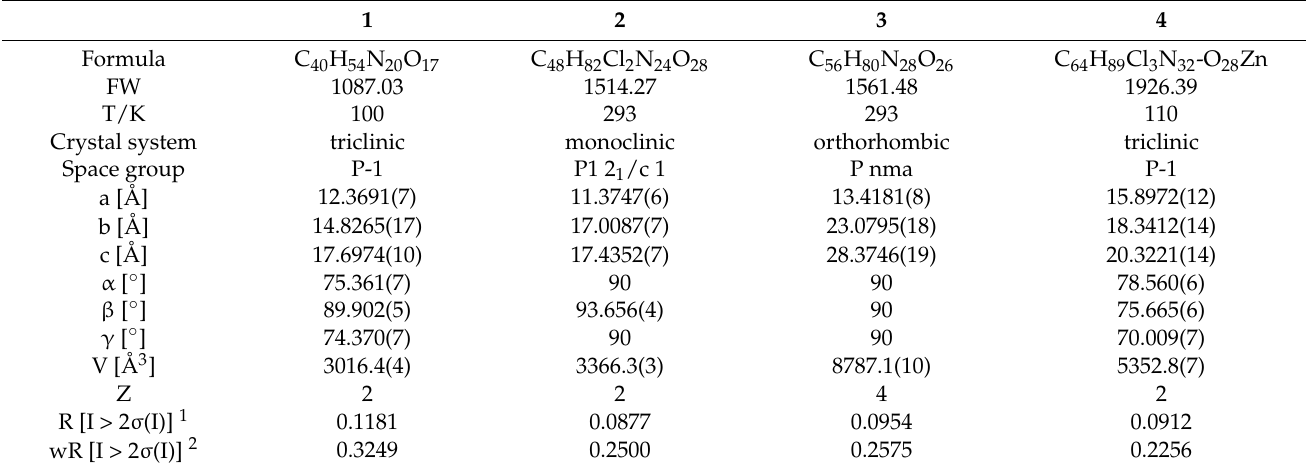
Table 5. Summary of single crystal X-ray diffraction results for compounds 1–4